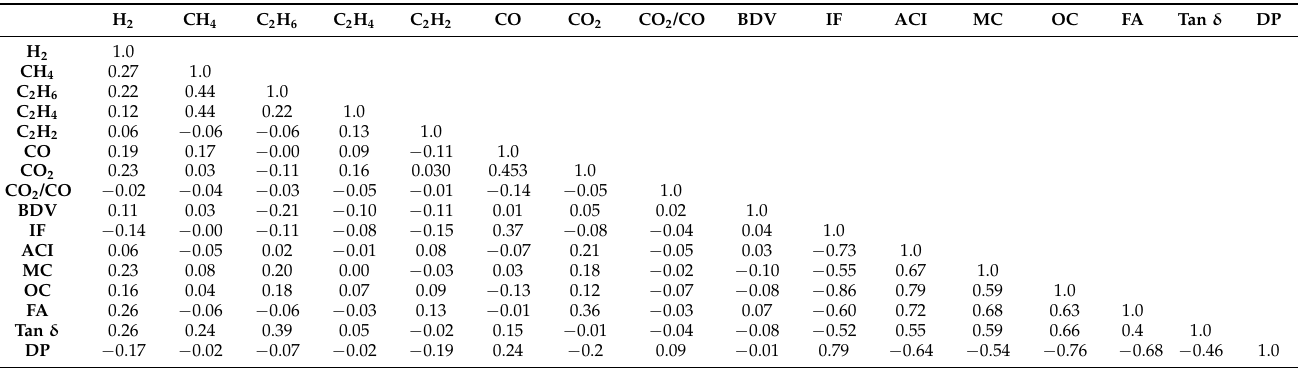
Table 2. Correlation between 15 variables and the